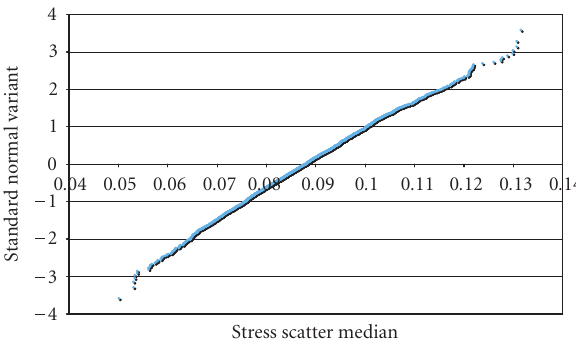
Figure 5: Normal probability plot of stress scatter sensitivity esti- mates (3000 statistical trials).